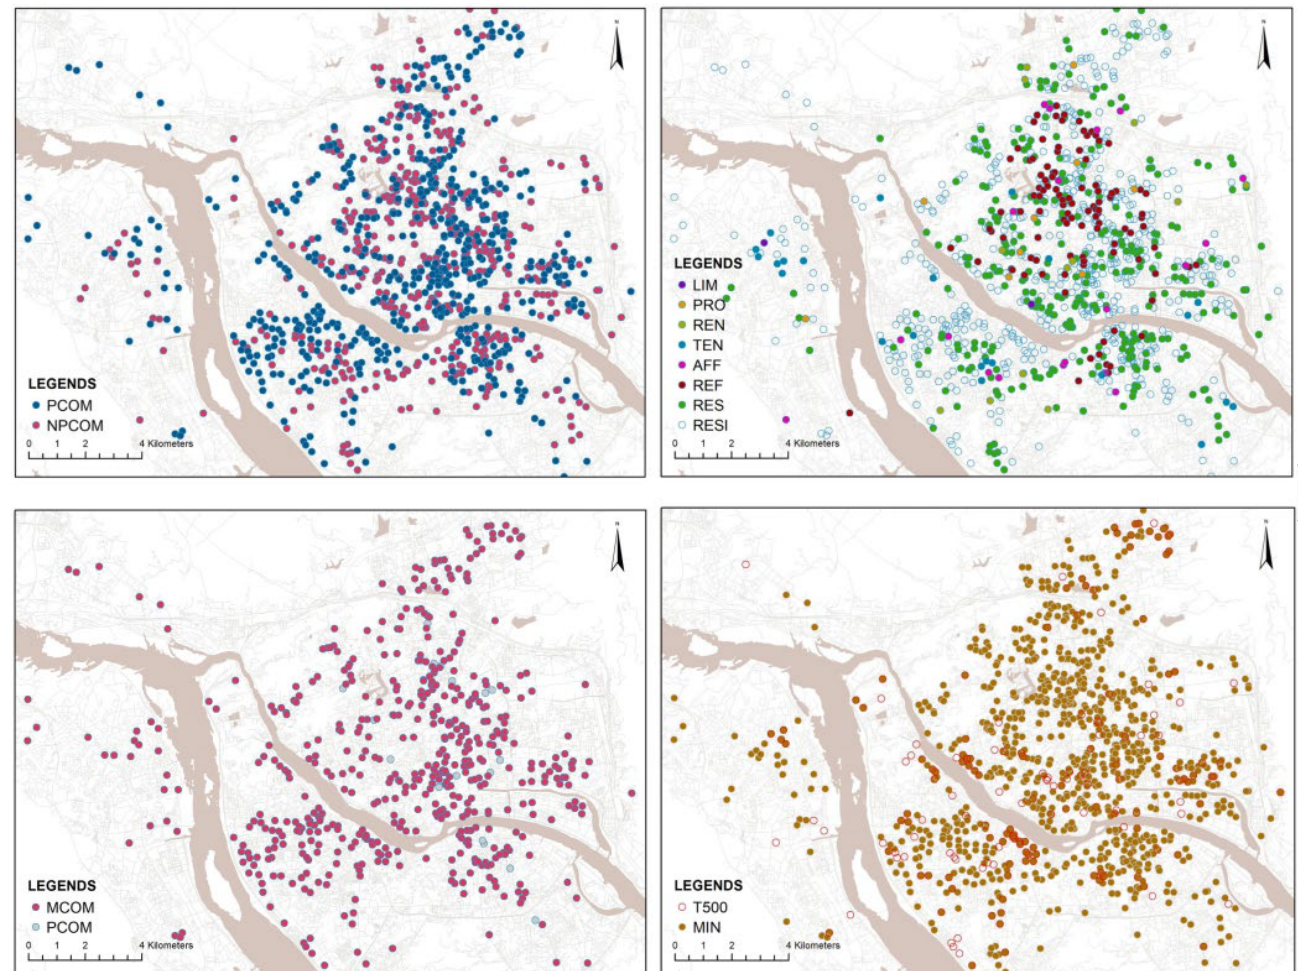
Figure 4. The current distribution of different types of residences and developers.